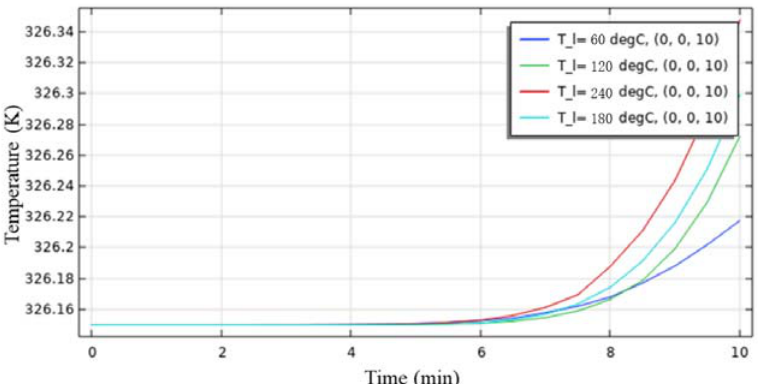
Figure 8. Comparison of temperature changes in cores with carbon dioxide injected under different injection gas temperatures when the initial water saturation is 35%.